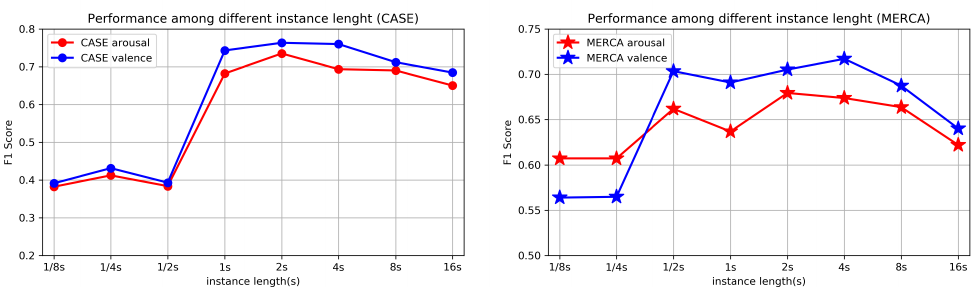
Figure 7. Comparison of the performance among different instance lengths: W-F1 of binary classifi- cation